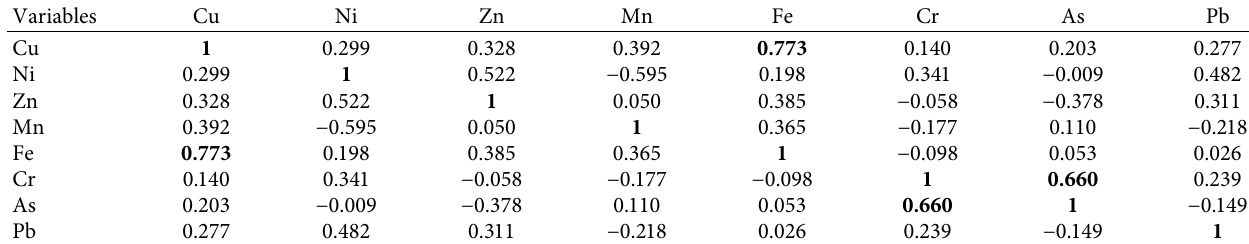
Table 5: Correlation matrix between heavy metals determined in sediment samples.